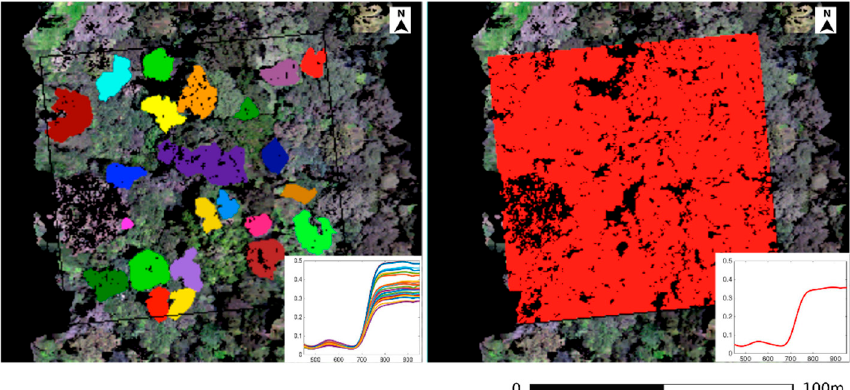
Figure 2. ( Left ) Tree crown spectra extracted from Ankasa 01 with NDVI < 0.6 and shadows masked. Spectra were only extracted for trees from which field data were taken and that exhibited crowns that lay > 50% in direct sunlight. ( Right ) Average plot spectrum extracted from Ankasa 01 with NDVI < 0.6 and shadows masked.